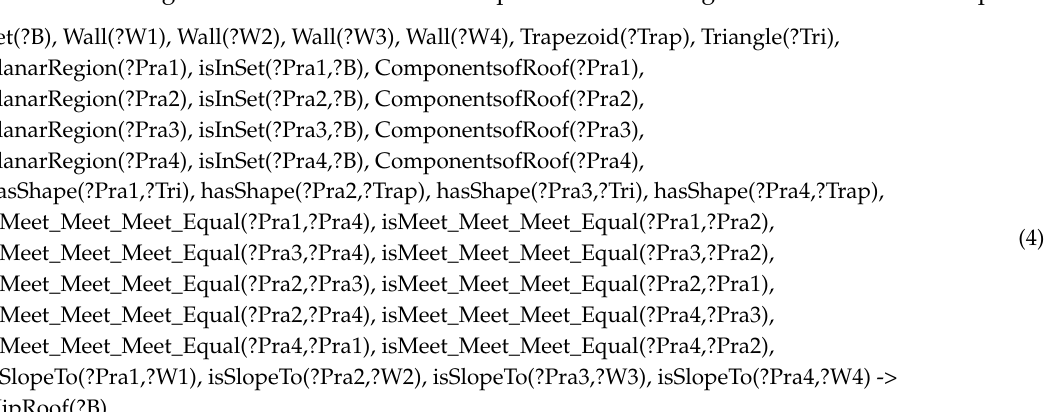
Figure 13. ( A ) Segmentation results; ( B ) boundaries and ( C – E ) the process of the determination of topological relations among components extracted from point cloud.